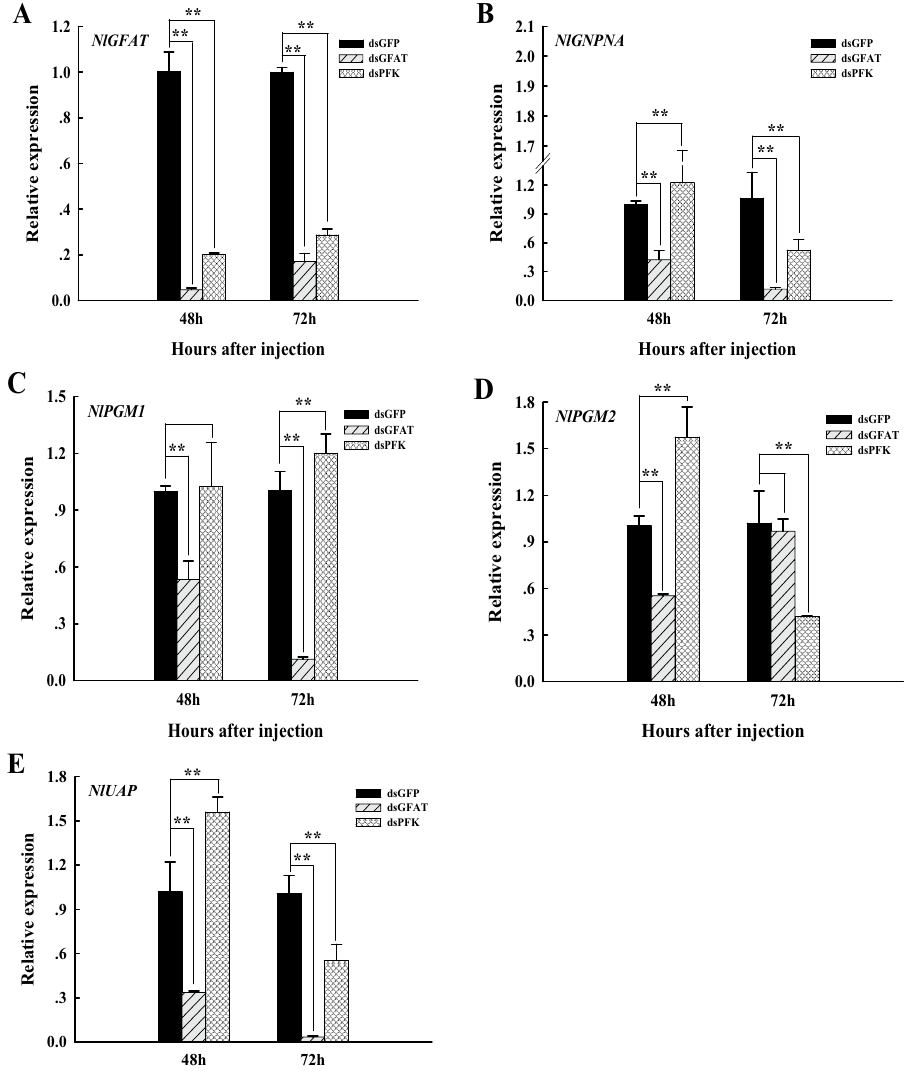
Figure 5. Relative expression levels of chitin biosynthesis-related genes at 48 h and 72 h after dsRNA injection. GFAT, glutamine:fructose-6-phosphate aminotransferase; PFK, phosphofructokinase; GAPNA, glucosamine- 6-phosphate N -acetyltransferase; PGM, phosphoacetylglucosamine mutase; UAP, UDP-N-acetylglucosamine pyrophosphorylase. The expression of GFAT ( A ), GNPNA ( B ), PGM1 ( C ), PGM2 ( D ), and UAP ( E ) was determined by quantitative real-time PCR with 18S RNA as the internal control. The N. lugens used for RNAi microinjection were at the 1st day of the 5th instar nymph stage and dsGFAT or dsPFK injection were used as test groups whereas the dsGFP injection was used as the control group. Values are the average of three sets of data and standard errors were calculated. *, significant differences ( P < 0.05); **, extremely significant differences ( p <